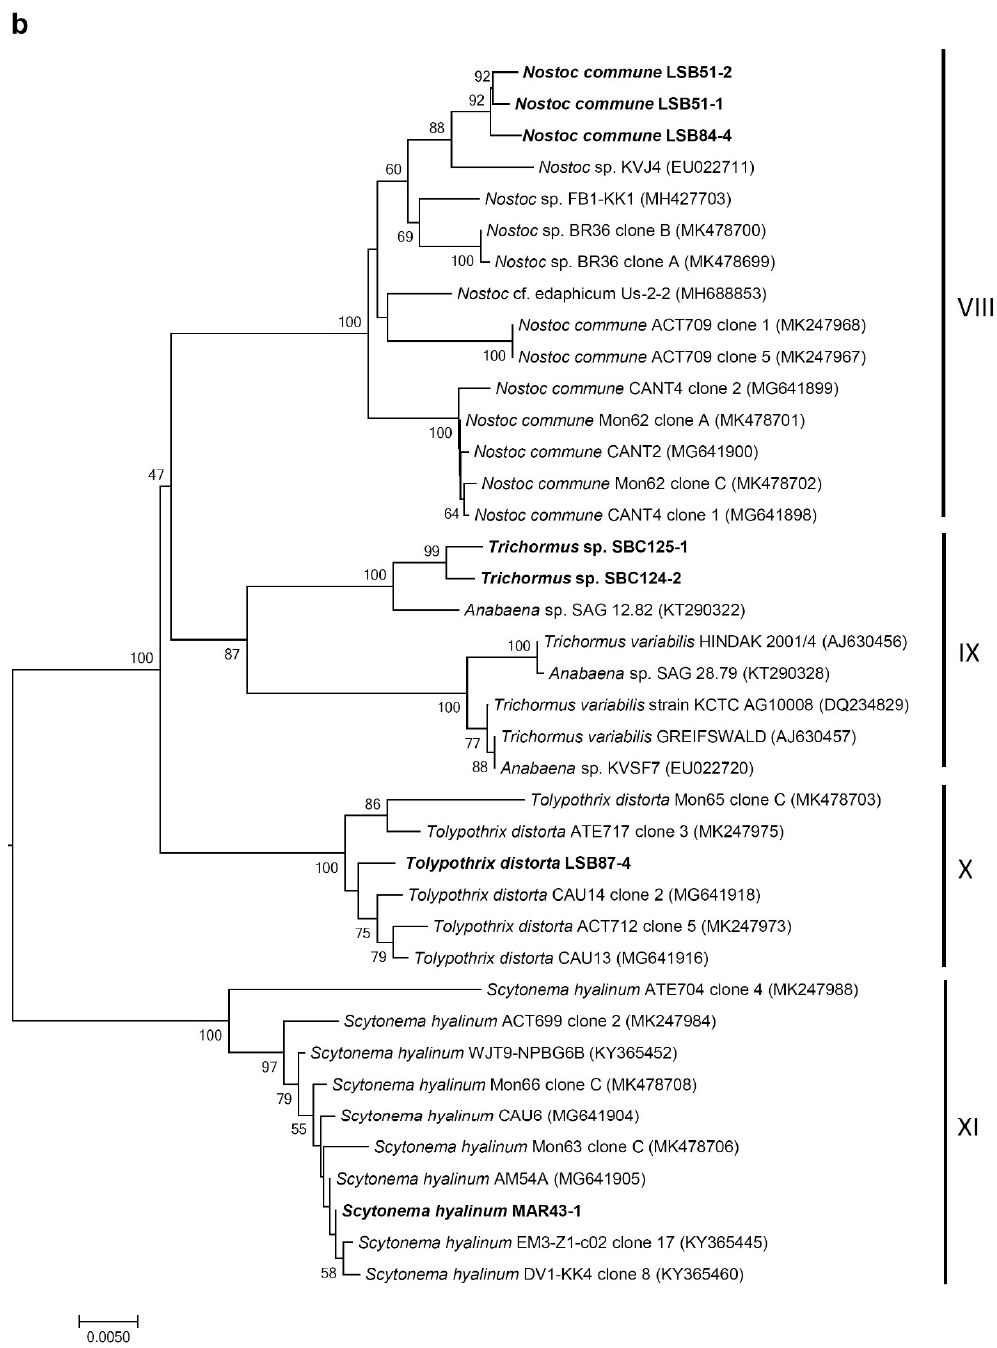
Figure 3. ( a ) Phylogenetic tree obtained by the neighbor-joining method based on the analysis of the 16S rRNA gene, showing the position of the sequences of the isolated strains obtained in the present study (in bold). ( b ) heterocystous cyanobacteria expanded. Numbers near node indicate bootstrap values greater than or equal to